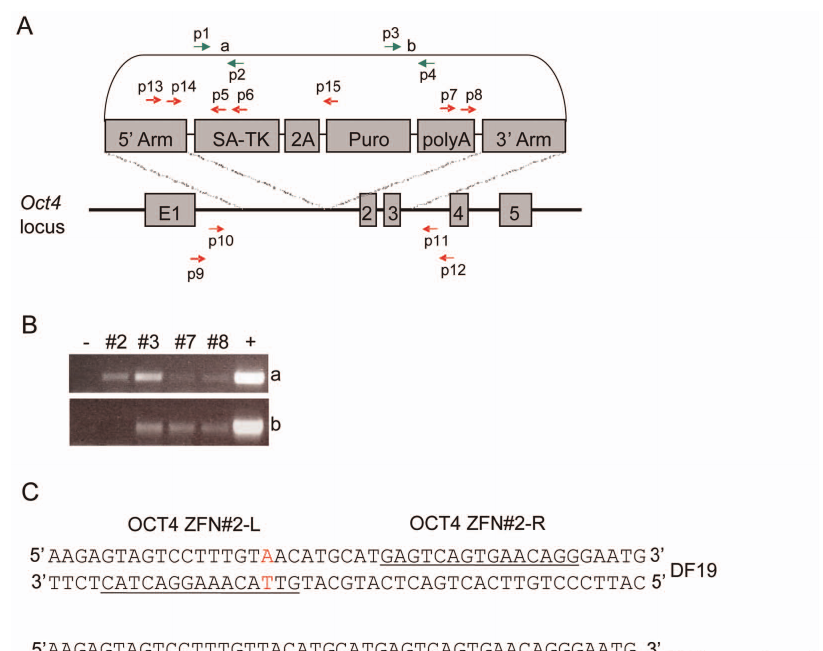
Figure 4. PCR analysis of DF19 iPSC clones. A. Schematic overview depicting the OCT4-TK-2A-Puro donor plasmid and PCR primers used. B. PCR analysis of genomic DNA from DF19 clones # 2, 3, 7 and 8 using the p1/p2 and p3/p4 primer pairs specific for the plasmid backbone. The resulting PCR products are referred to as ‘‘a’’ and ‘‘b’’. C. Analysis of the target sequence for the OCT4 ZFN # 2. The binding sites for the left (L) and right (R) ZFN are underlined. The single-nucleotide change in DF19 genomic DNA is shown in